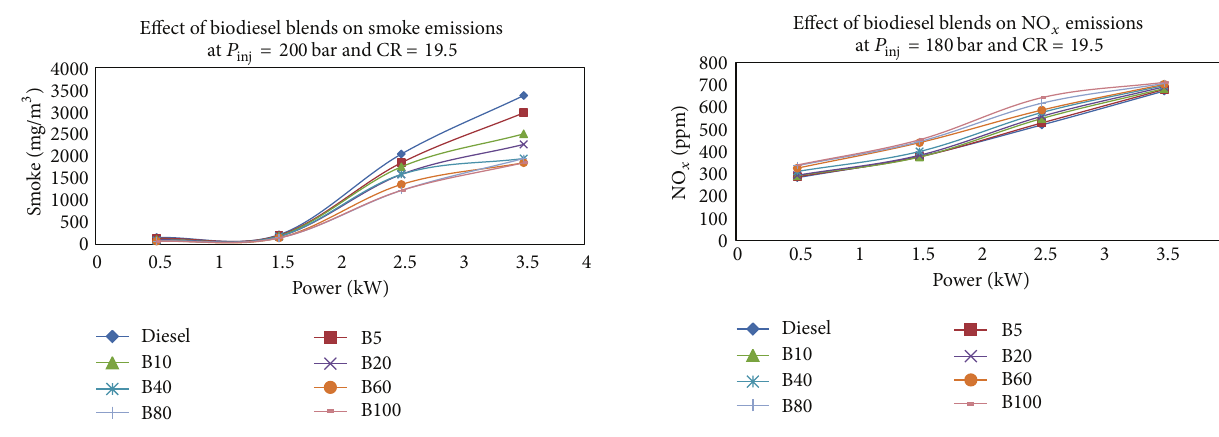
Figure 15: Variation in smoke opacity for various biodiesel blends 200 bar and CR 19.5. at 𝑃 inj